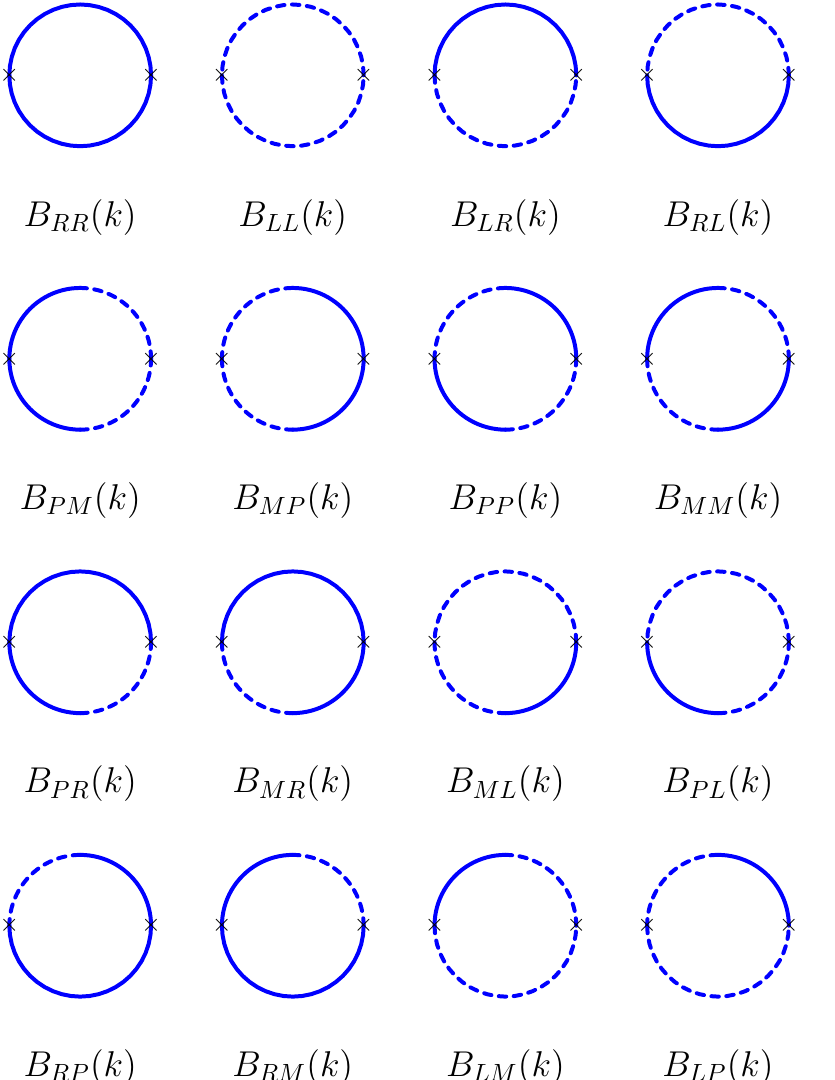
Figure 27. PV one loop B type integrals in SK theory. The momentum and mass corresponding to the lower propagator is denoted by p (cid:22) and m respectively, whereas the momentum and mass corresponding to the upper propagator are q (cid:22) and (cid:22) m respectively. The momenta p and q are taken to (cid:13)ow anti-clockwise in the